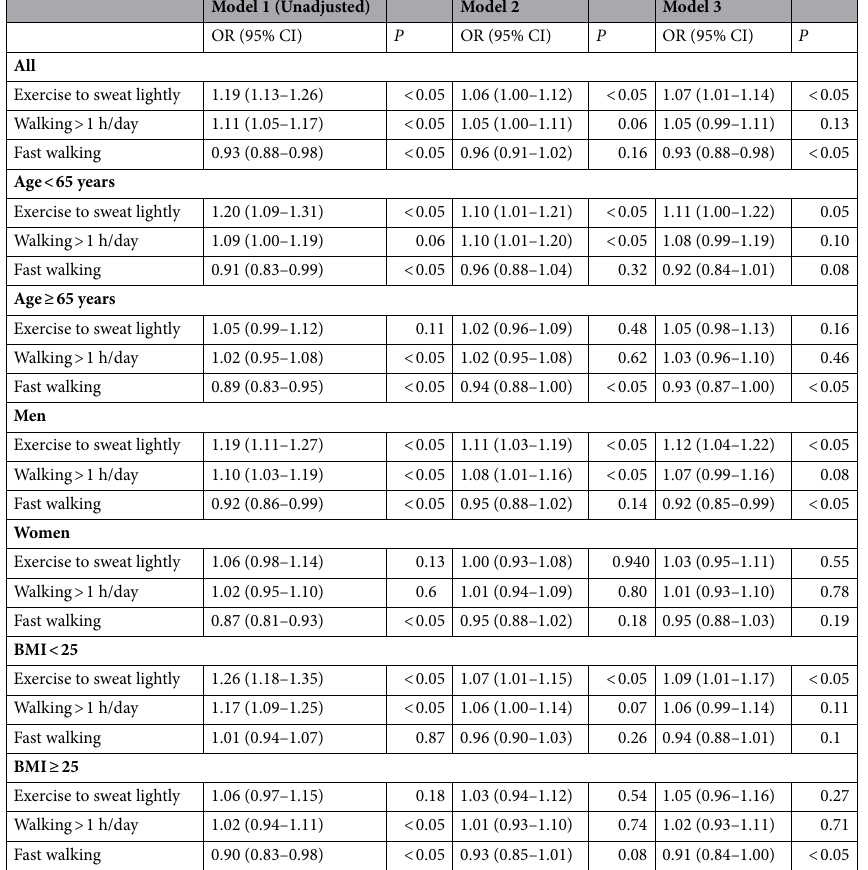
Table 2. Unadjusted and multivariable-adjusted odds ratio for the risk of new-onset diabetes mellitus of three physical activity measures. OR odds ratio, CI confidential interval, BMI body mass index, SBP: systolic blood pressure. Model 2 (sex, age and BMI, if not applicable to sub-group variables). Model 3 (sex, age, BMI, SBP, current smoking, drink, weight gain over 10 kg from 20-years, weight change of 3 kg within 1 year, exercise to sweat lightly, walking > 1 h/day and fast walking, if not applicable to sub-group